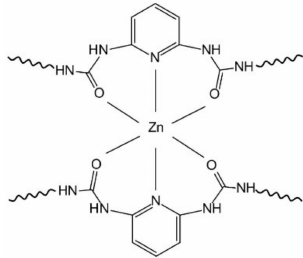
Figure 4. ( a ) UV-vis spectra variation with titration of a solution of zinc salt into diluted PUU-HMD solution in DMF; ( b ) variation of absorbance at specific wavelength ( λ = 269 nm and 290 nm) plotted to the Zn 2 + / HMD molar